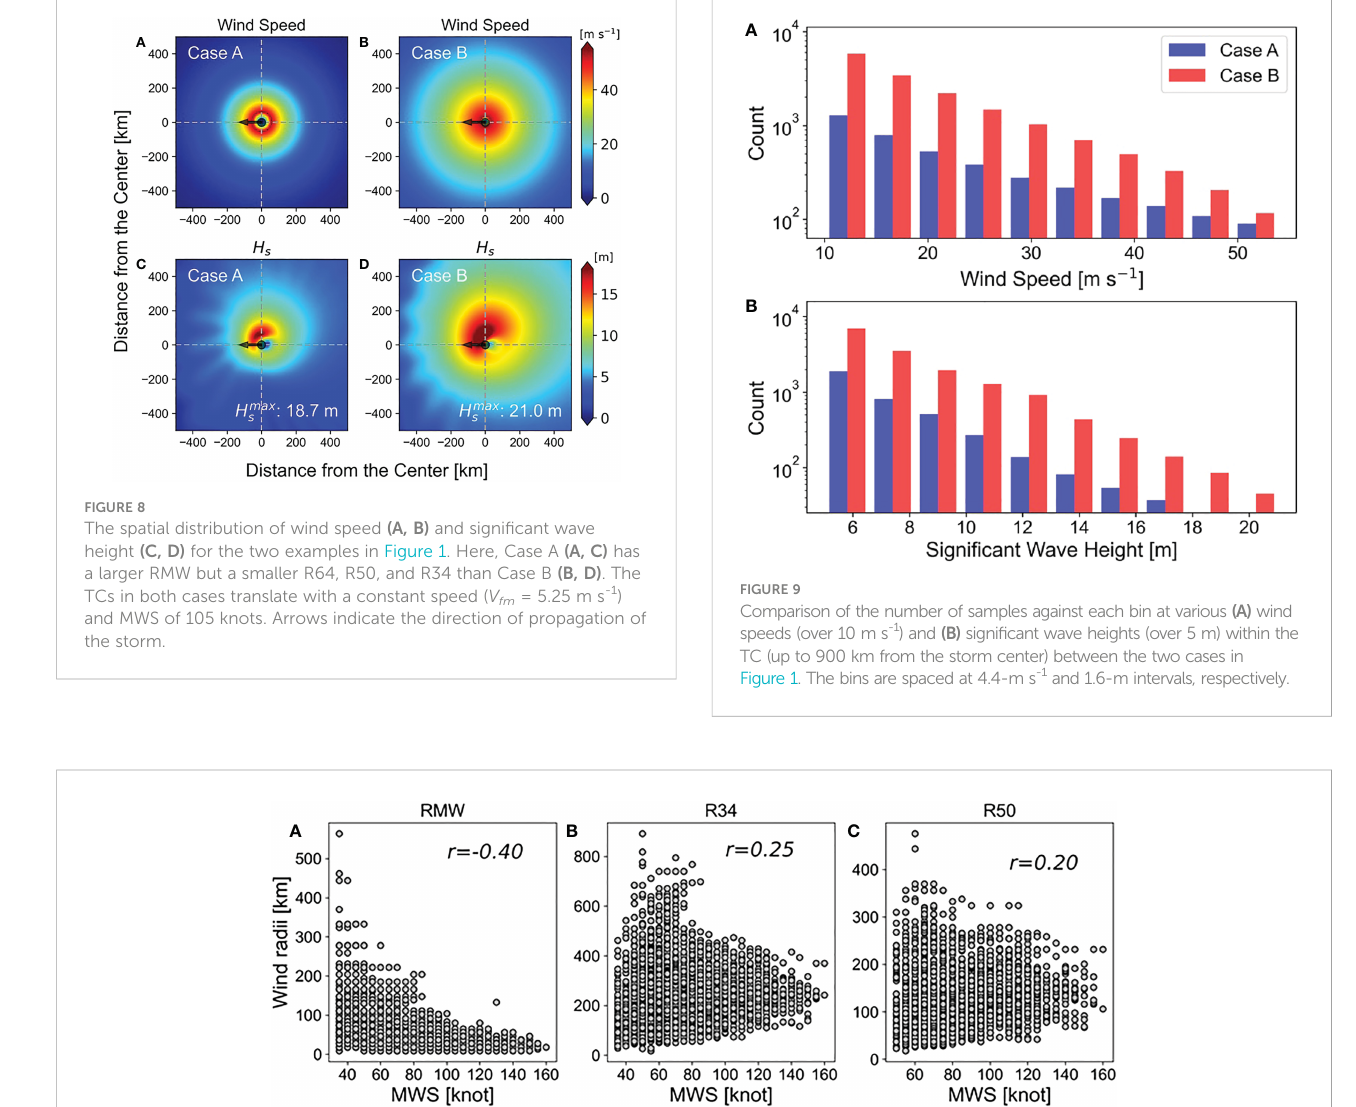
FIGURE 10 Relationship between TC intensity (i.e., MWS) and three TC size parameters: RMW (A) , R34 (B) , and R50 (C) . The data were obtained from North Atlantic hurricanes from 1988 to 2017. The correlation coef fi cients ( r ) between MWS and TC size parameters are indicated in each